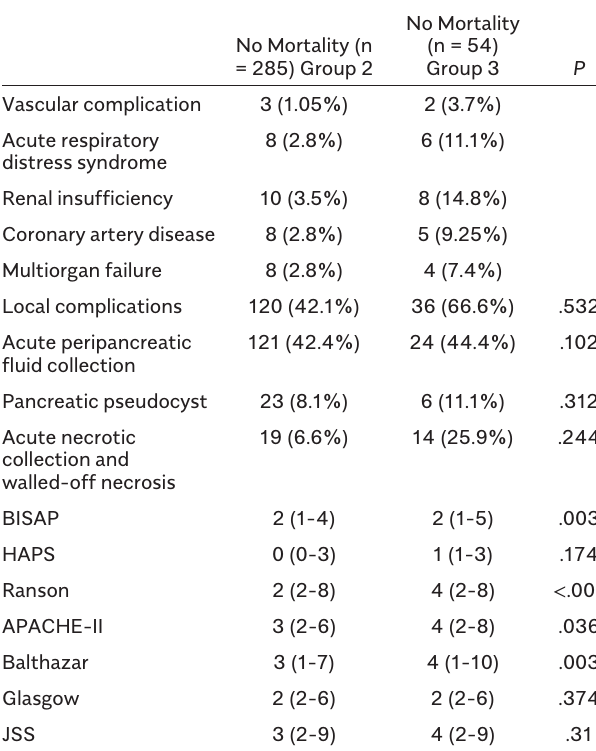
Table 4. Differences Between Alive Patients Aged 65-80 Years and Over 80 Years